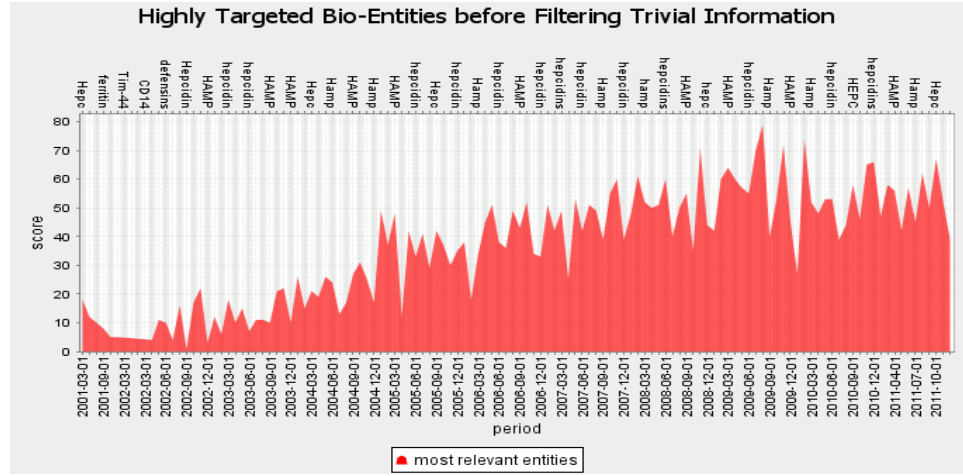
Figure 9. Highly scored proteins over the Hepcidin decade when the background is included